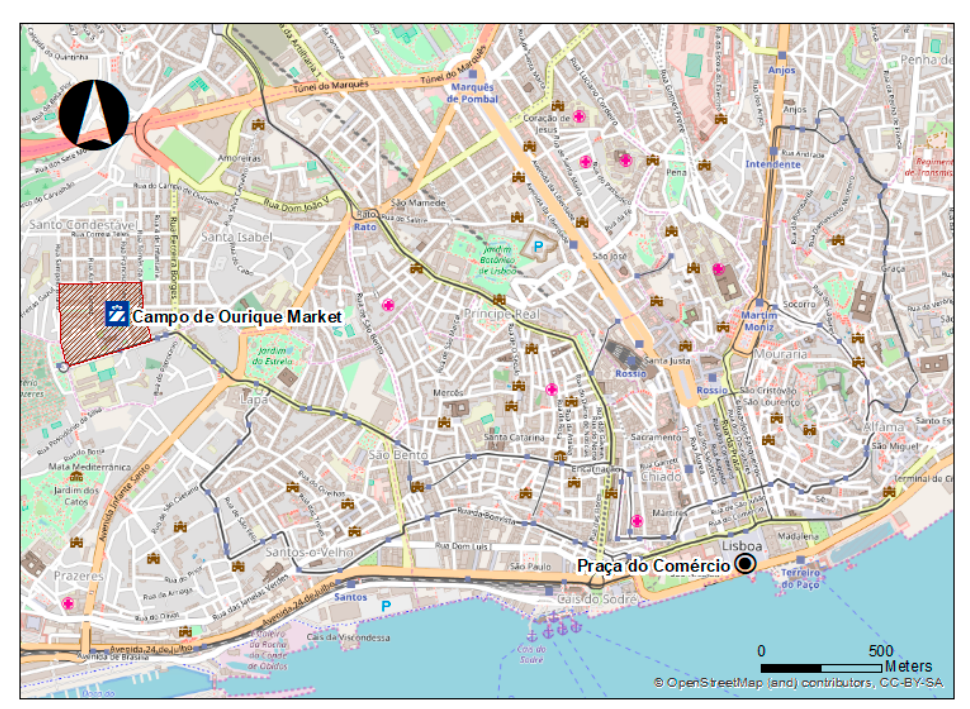
Figure 3. Location of Campo de Ourique market in relation to the traditional city centre (Praça do